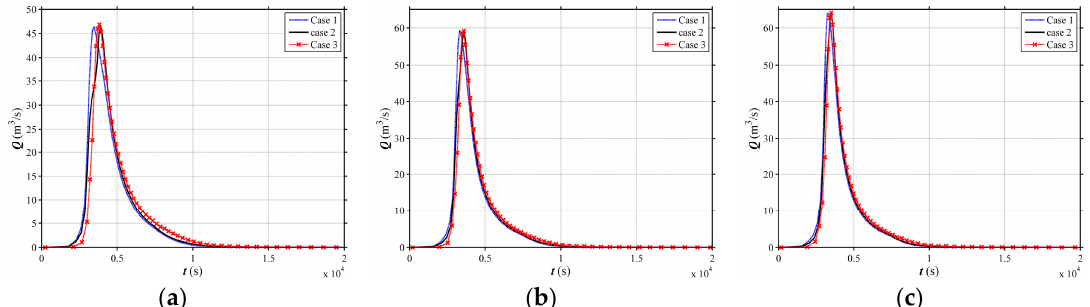
Figure 12. Simulated hydrographs at the outlet of the critical channel slopes ( i 1 c ) in the V-shaped catchment with different slopes ( i 2 ) ( a ) i 2 = 0.18 ( b ) i 2 = 0.58 ( c ) i 2 = 1.19.